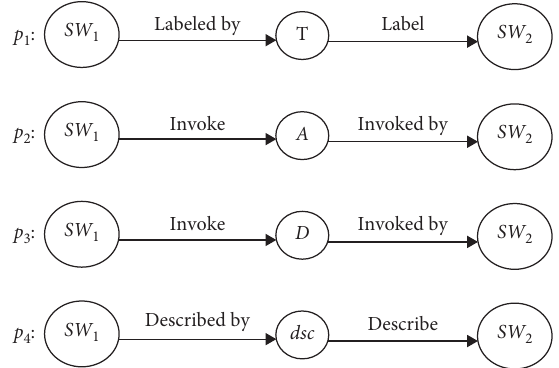
Figure 3: Four types of metapaths under the HIN-based scientific workflow representation